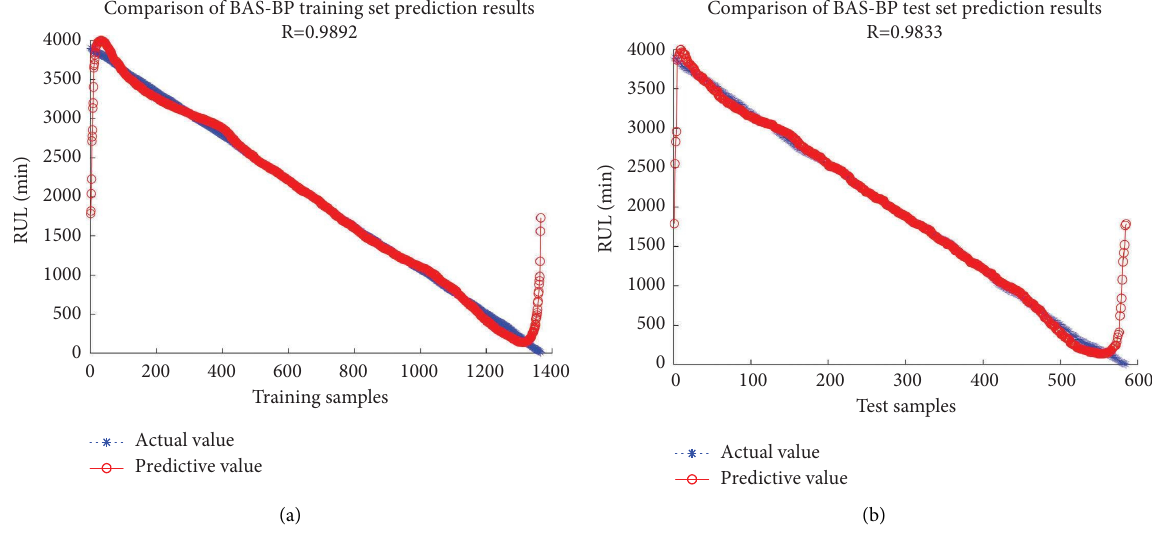
Figure 14: BAS-BP model prediction results of no. 1. (a) Training set. (b) Test set.